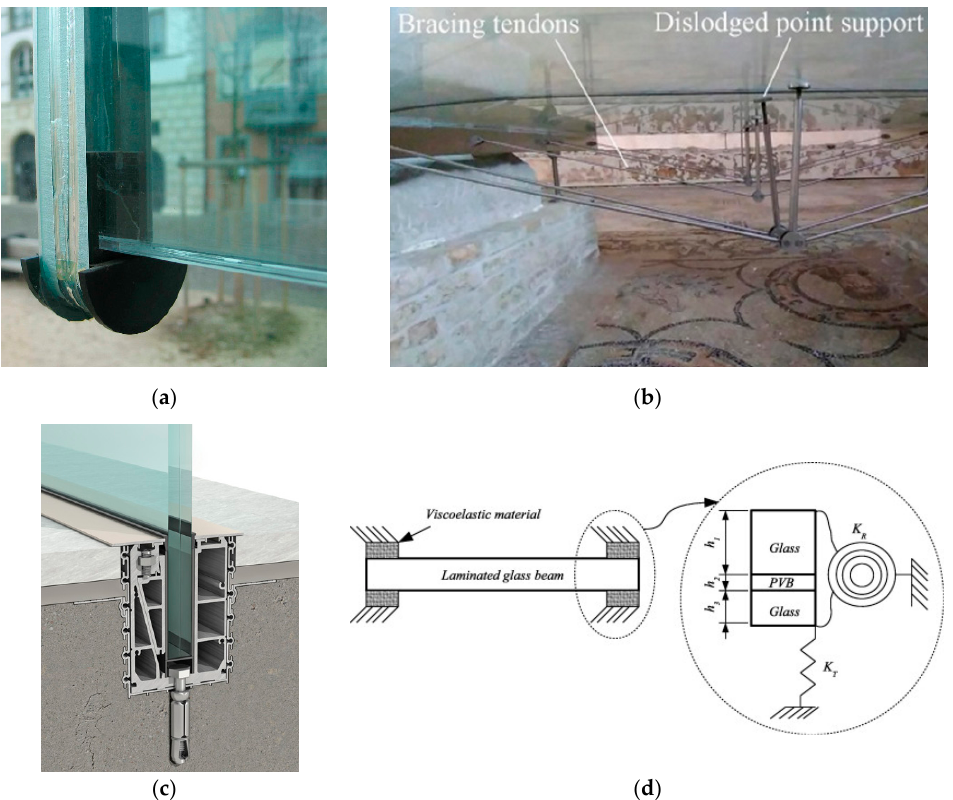
Figure 1. Examples of typical restraints for structural glass applications in buildings. ( a ) Beam-to-roof adhesive joint within a glass canopy (detail); ( b ) simply supported glass walkway (with dislodged mechanical restraints); ( c ) clamped glass balustrade; ( d ) mathematical model of a laminated glass beam with viscoelastic supports (picture reproduced from [18], with permission from Elsevier—copyright license number 4486030094766 (December 2018)).